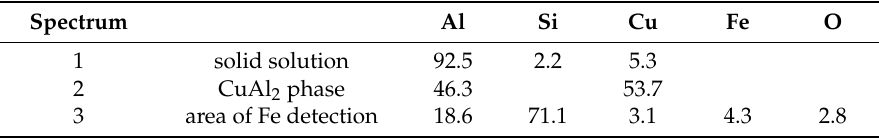
Figure 10. TEM bright field images showing ( a ) a CuAl 2 particle and ( b ) area of Fe detection in the intercellular network (numbered points represent locations of point EDS analyses). Table 3. Point EDS analyses (wt.%) (location of points in Figure 9).